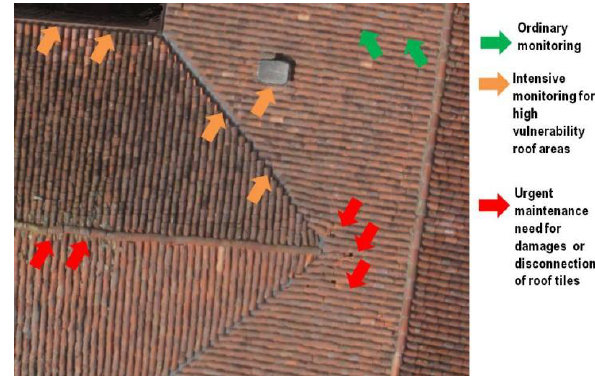
Figure 22. A proposal of different level of damages and vulnerable elements on the roof. The reading of roof deterioration con be applied on a 0.02 m resolution texture.